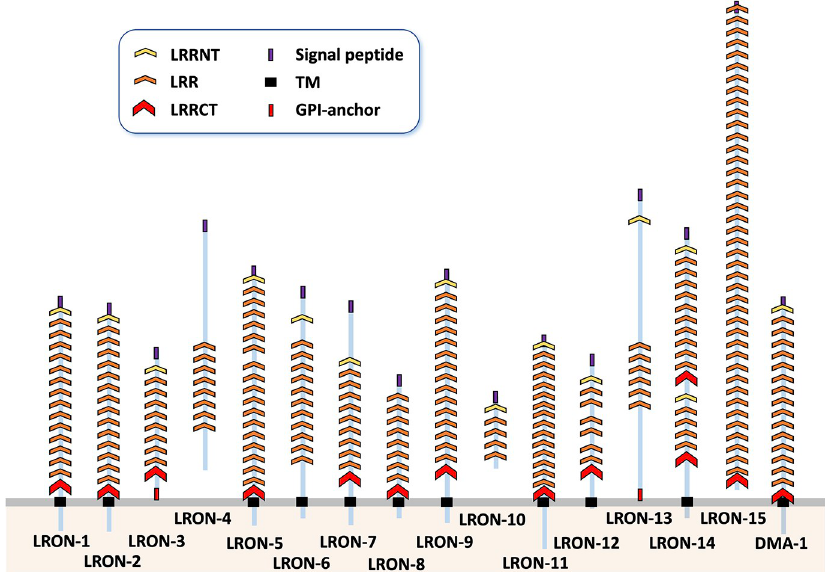
Fig 2. Domain organization of LRON-family members. Leucine-Rich Repeat (LRR) domains are depicted by orange chevrons, LRRNT caps (cysteine rich domains that often flank repeated LRR sequences) are yellow chevrons, and LRRCT caps are red chevrons. Transmembrane domains are in black, the signal peptides are purple, and GPI-anchors are red. The domain organization was determined by consulting SMART, Interpro and Phobius domain predictions [18–20]. LRR domains were also compared to the domains predicted by LRRscan [7].